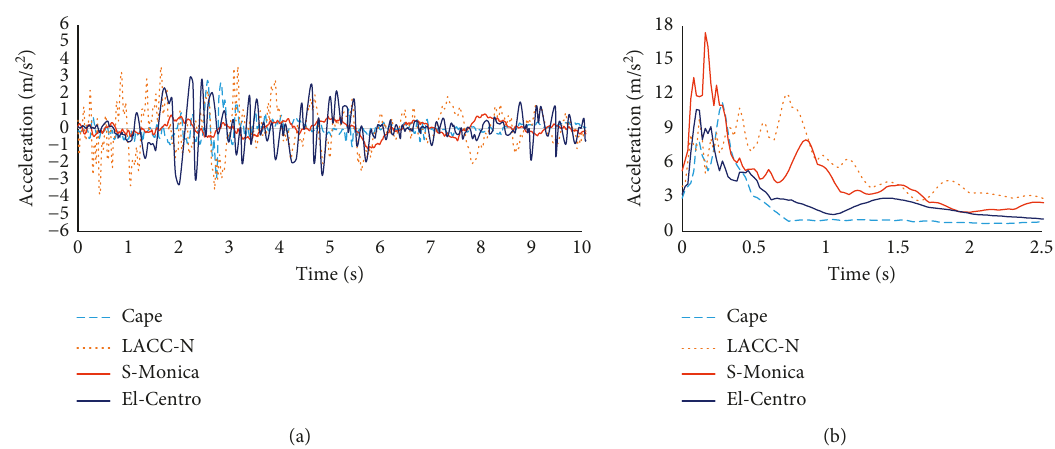
Figure 1: (a) Time histories and (b) spectral accelerations (5% damping) of the applied earthquakes.